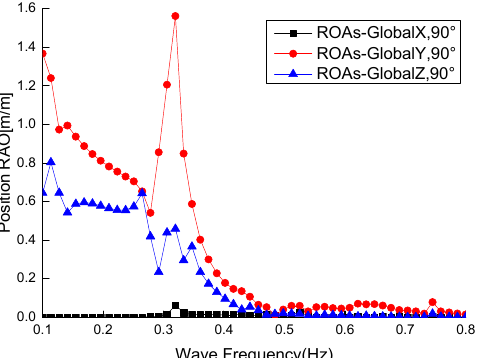
Figure 4. The way the value of the RAO in the X, Y, and Z directions varied with wave frequency.